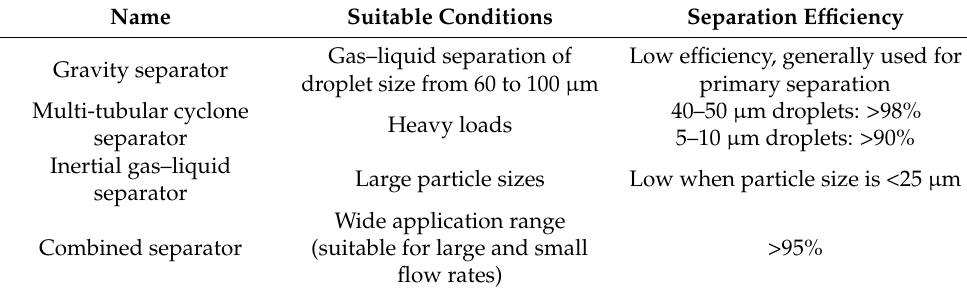
Table 19. Comparative analysis of the applicability of all